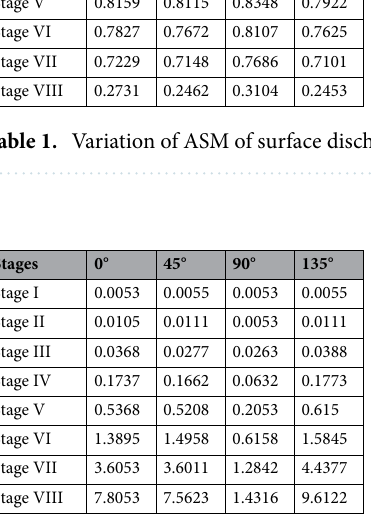
Table 2. Variation of CON of surface discharge images during AC flashover